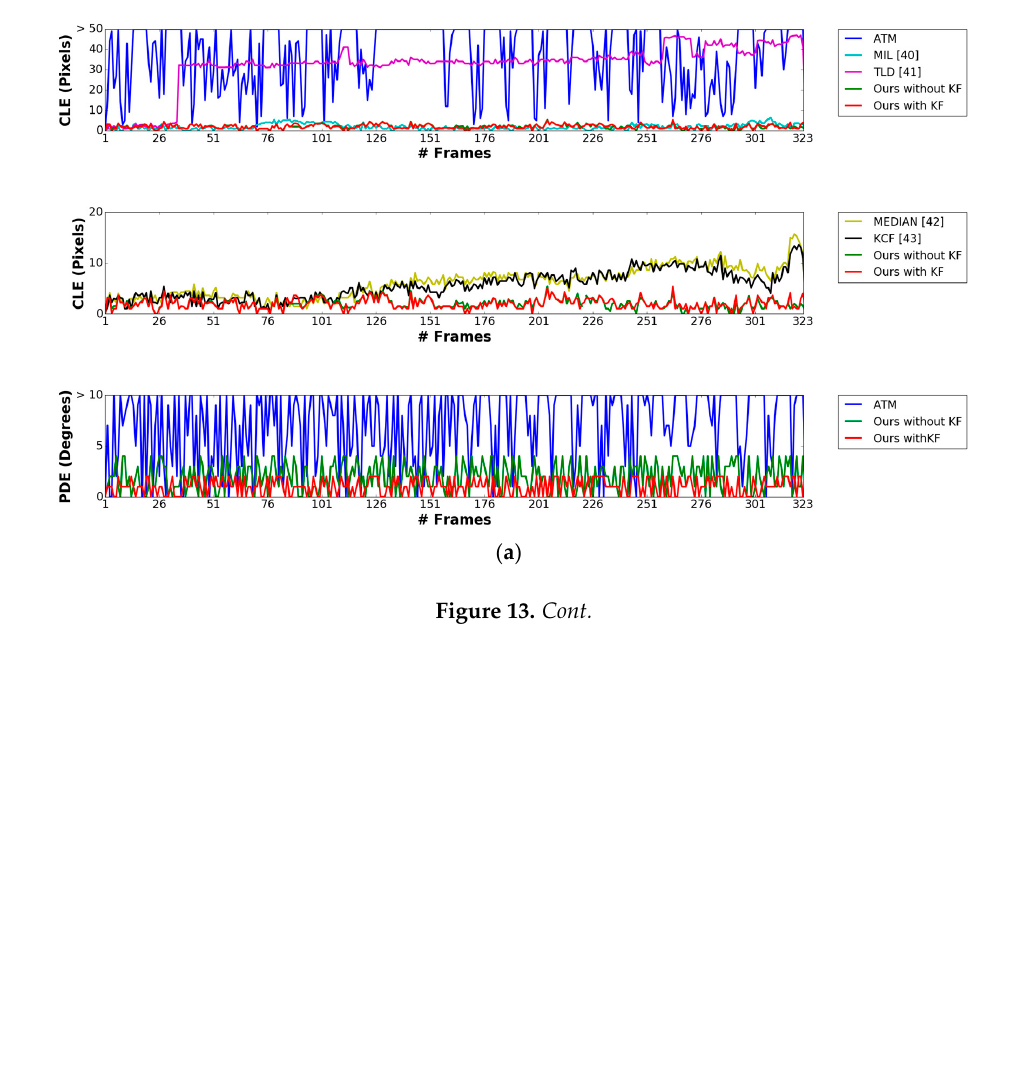
Figure 12. Comparisons of CLE and PDE obtained by our method with those obtained by other methods using sub-database 1 including the videos captured ( a ) in the morning, ( b ) in the afternoon, ( c ) in the evening, and ( d ) at night.